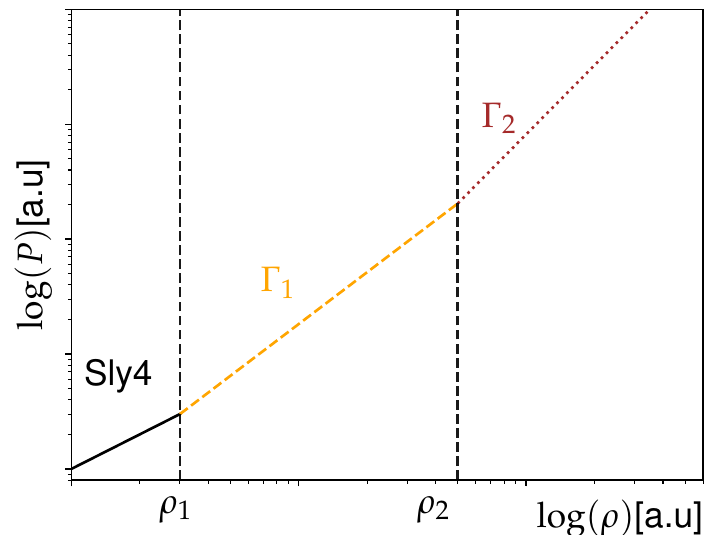
Figure 1. Piecewise model representation of the equations of state with the polytropic Equation (7). The black continuous line represents the SLy4 EoS region, the orange dashed line the EoS for first politrope and the red dotted line the EoS for the last politrope. The vertical lines represent the transition points ρ 1 and ρ 2 of each piece of the